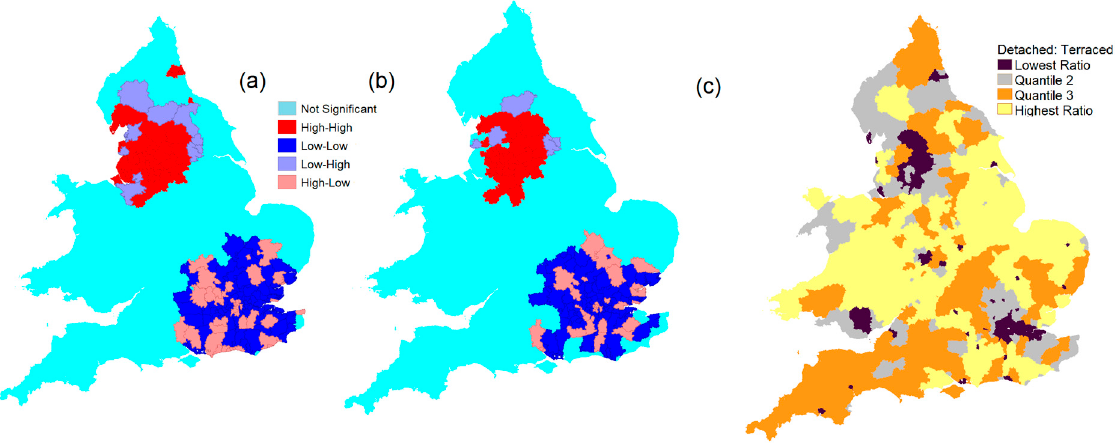
Figure 2. LISA Housing Maps. ( a , b ) are maps of local indicators of spatial association of house price–earnings ratio differentials. ( c ) is a quantile map of the number of sales of detached dwellings divided by the sales of terraced properties.